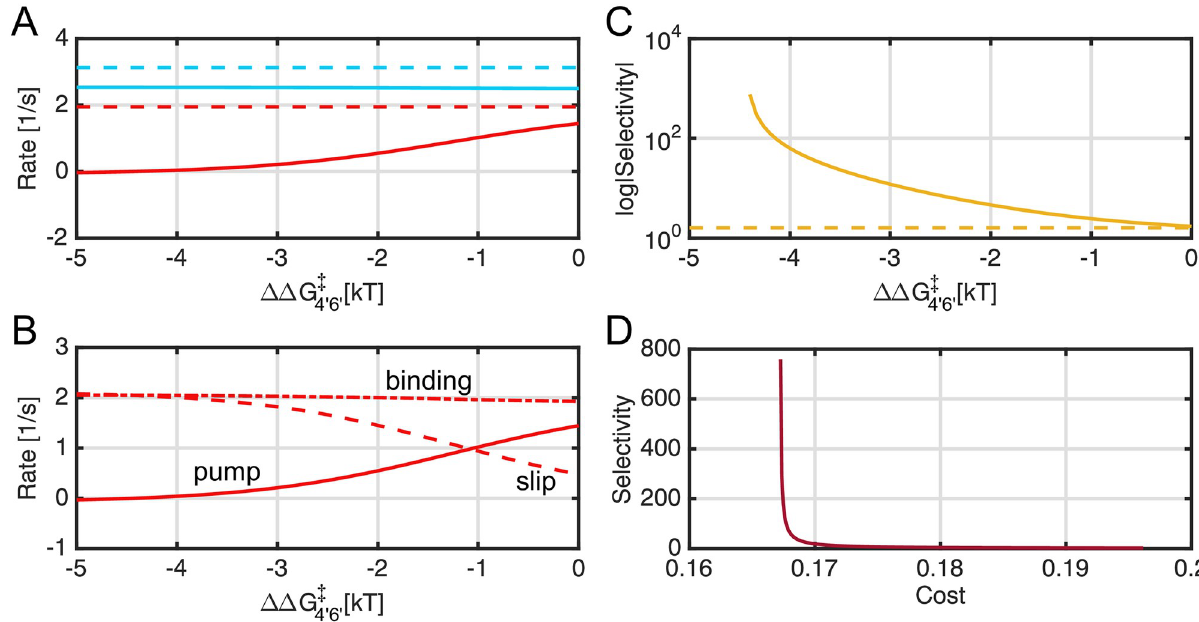
Fig 5. Flows, cost, and selectivity with discrimination added to the slip cycle. In addition to weak discrimination (1 k ) at the inward-transition B T state, the rate of partial outer gate opening was modulated by changing DD G z from -5 to 0 k . A) Net sugar (blue) and toxin (red) pumping as a B T 4 0 6 0 with (solid curves) and without (dashed curves) slip. Toxin import is reduced as outer gate opening becomes easier at negative function of DD G z 4 0 6 0 , but all other pumping fluxes are insensitive. Values at DD G z ¼ 0 on right correspond to values at -75 mV in Fig 4A. B) Toxin values of DD G z 4 0 6 0 4 0 6 0 pumping (solid), slipping (dashed), and binding (dash-dot) rates as a function of DD G z . Note that the pumping flow of toxin is approximately zero 4 0 6 0 ¼ -5 k B T . C) Selectivity ( σ ) as a function of DD G z . The selectivity with slip is solid gold, and the selectivity with the slip cycle removed is when DD G z 4 0 6 0 4 0 6 0 is varied in panels A-C. The cost ( C ) varies over a narrow range starting near 0.2 when DD G z ¼ 0 , dashed gold. D) Cost-selectivity curve as DD G z 4 0 6 0 4 0 6 0 and dropping below 0.17 as DD G z approaches -4.5 k B T at which point σ increases beyond 800. The membrane potential was held at -75 mV for all 4 0 6 0 calculations.